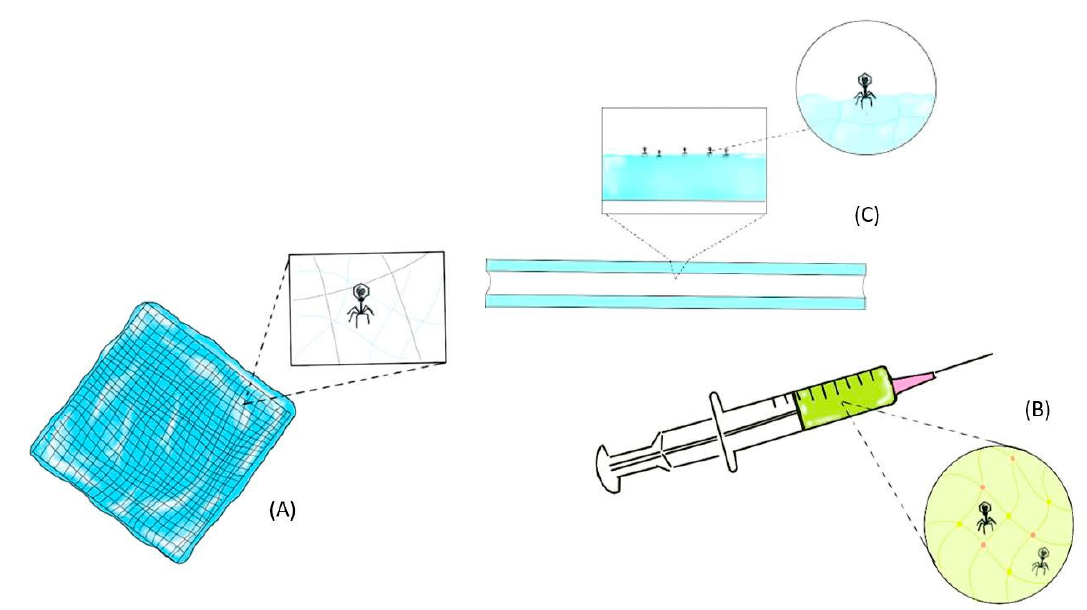
Figure 2. Topical application of phage-delivering hydrogel formulation as a wound dressing ( A ), injectable phage-delivering hydrogel formulation via syringe ( B ) and phage-delivering formulation via a hydrogel-coated catheter ( C ). Table 2. Phage-delivering hydrogels for the prevention of orthopedic implant-associated bone infections. Hydrogel Target Bacteria Phages Study Key